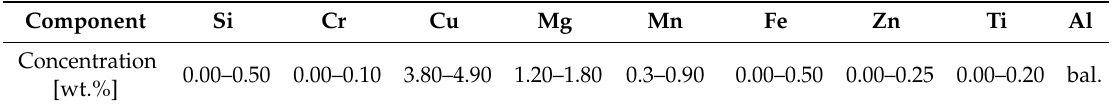
Table 1. Chemical composition of the AW-2024 alloy